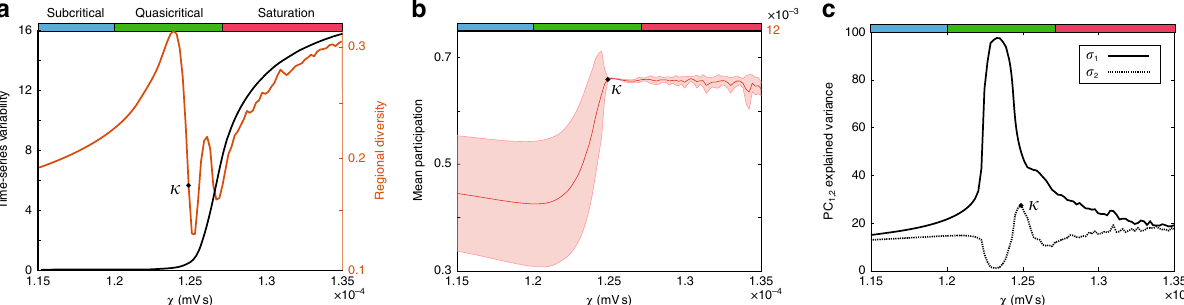
Fig. 4 Network topology and dimensionality. a Mean participation — which quanti fi es the extent to which a region functionally connects across multiple modules (these were calculated using a weighted version of the Louvain algorithm across all simulations). ( b : left) Average time-series variability; ( b : right) Regional diversity — de fi ned as the variance in the upper triangle of the region-wise functional connectivity matrix. c Explained variance captured by PC 1 , σ 1 , and PC 2 , σ 2 . κ demarcates corresponding points in all